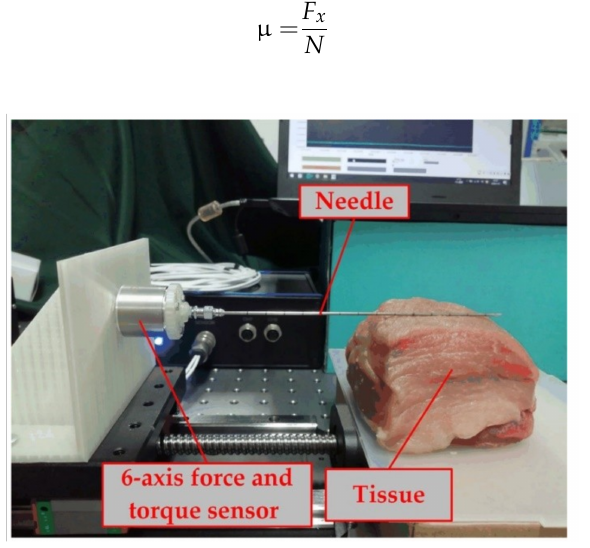
Figure 4. Friction coe ffi cient measuring device.